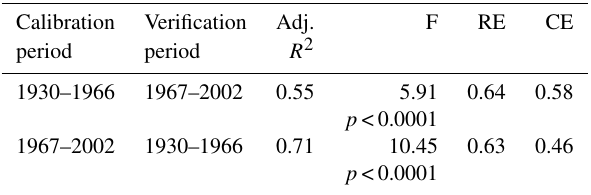
Table 5. Calibration and cross-validation statistics for the Turkey temperature reconstruction